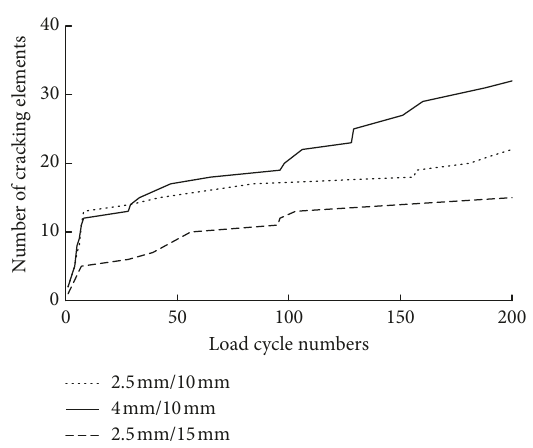
Figure 21: The relationship between the number of cracking elements and load cycle